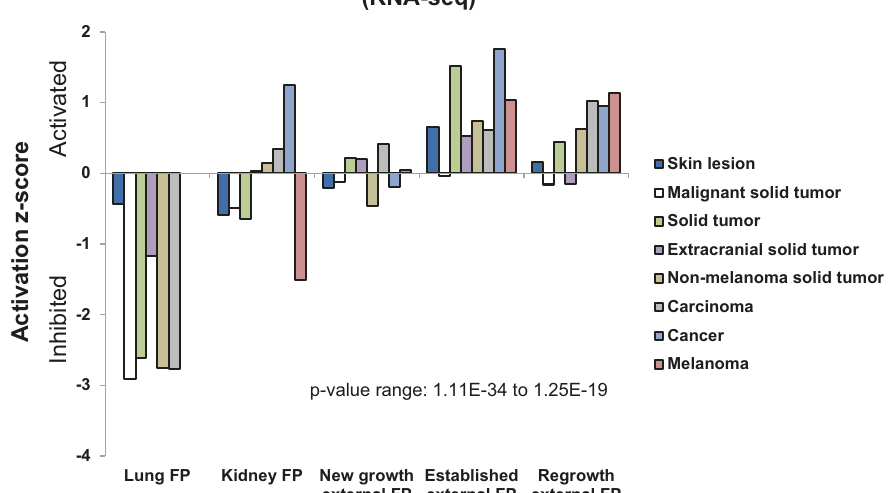
Fig. 2 Gene level and gene ontology (GO) term analyses of differentially expressed transcripts in each tumor type. a Volcano plot of genes differentially expressed between fi bropapillomatosis tumors (all types) and nontumor tissue (all types) as determined by DESeq2 analysis of the RNA-seq samples. Transcripts were considered signi fi cant if passing the following cutoffs: adjusted P value of <0.05 and log 2 fold change of >2 and ≤ 2. b Expression levels of CRABP2, as detected by RNA-seq, in nontumor tissue and tumors of patients with varying rehabilitation outcomes. N = 89 samples. Per outcome: released = seven turtles; died/euthanized = fi ve turtles. Box plot with Tukey whiskers. P values of inter-group comparisons are shown below the x-axis (Mann – Whitney U tests). n = 89: 20 nontumor, 23 poor-outcome tumor and 46 good outcome tumor samples. c Activation/inhibition z scores of the six GO terms common to the top 20 GO terms of all sample comparisons, plus the ‘ Cancer ’ and ‘ Melanoma ’ GO terms, as detected by IPA, ranked by P value (calculated by right-tailed Fisher ’ s exact test, with Benjamini – Hochberg